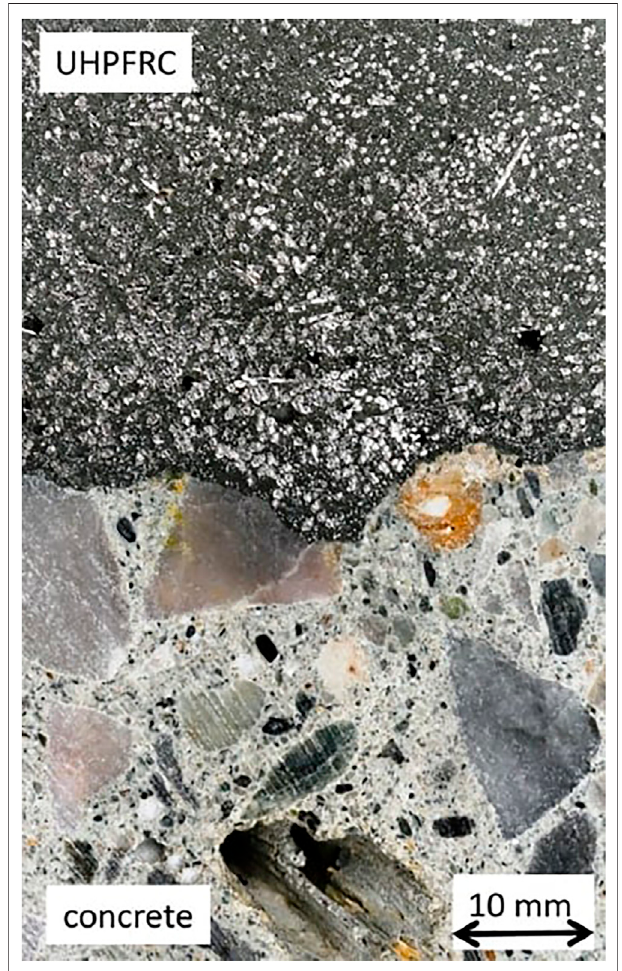
FIGURE 1 | UHPFRC — concrete core showing the apparent difference between the two materials. Adapted from (Brühwiler, 2018).